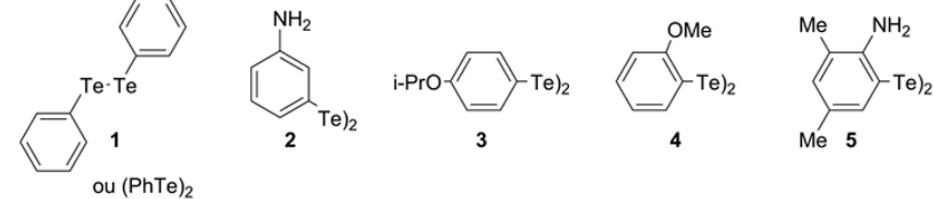
Fig. 1 – Molecular structures of diorgano ditellurides used in toxicological